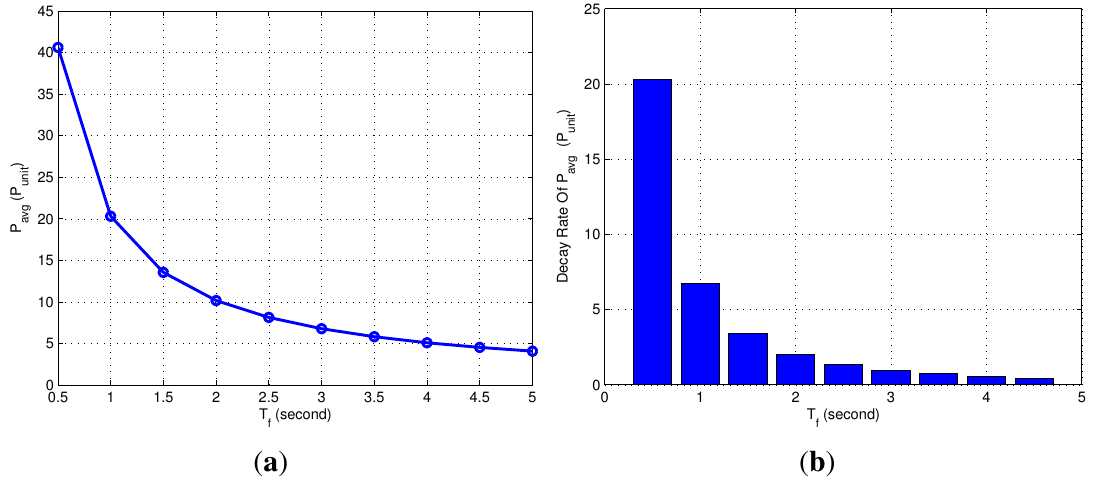
Figure 10. ( a ) The average cycle power consumption based on different sleep times; ( b ) the average cycle power attenuation rate based on different sleep